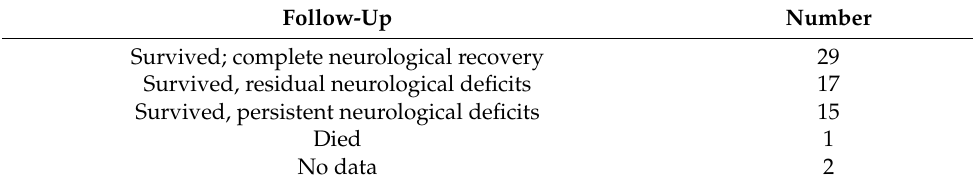
Table 2. Follow-up findings of pediatric ISCA